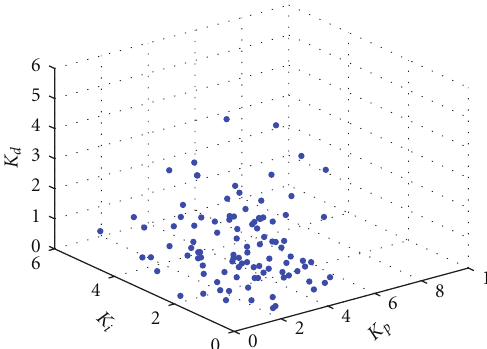
Figure 12: The initial search space of parameters ( K p , K i , K d ).